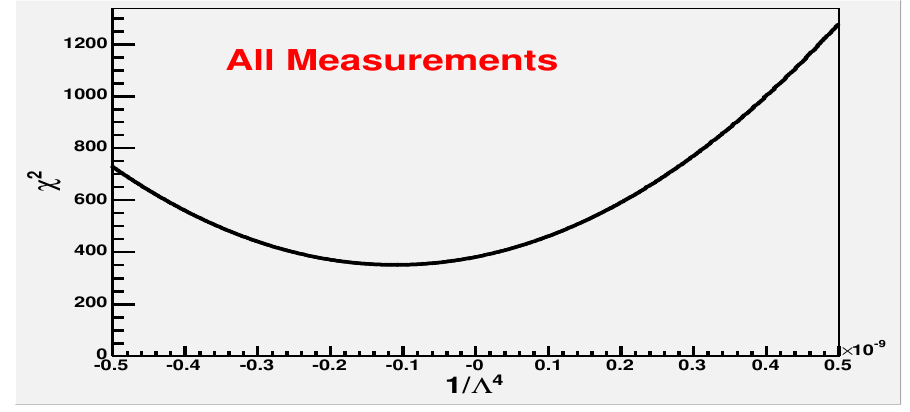
Figure 9. A minimum in the χ 2 fit with P = 1/ Λ 4